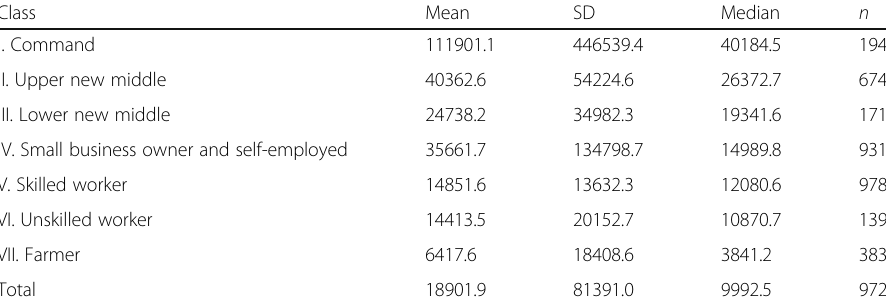
Table 8 Annual income by class in transitional China: CGSS2010 Class Mean SD